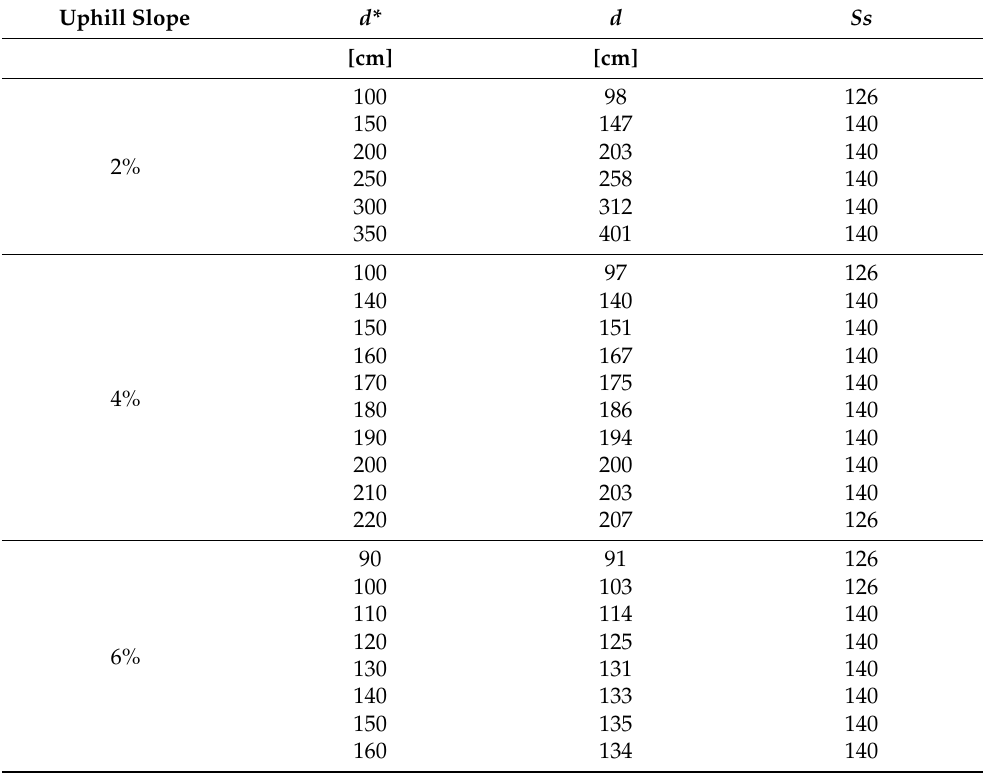
Table 6. Uphill vertical track experimental results with car target on track.